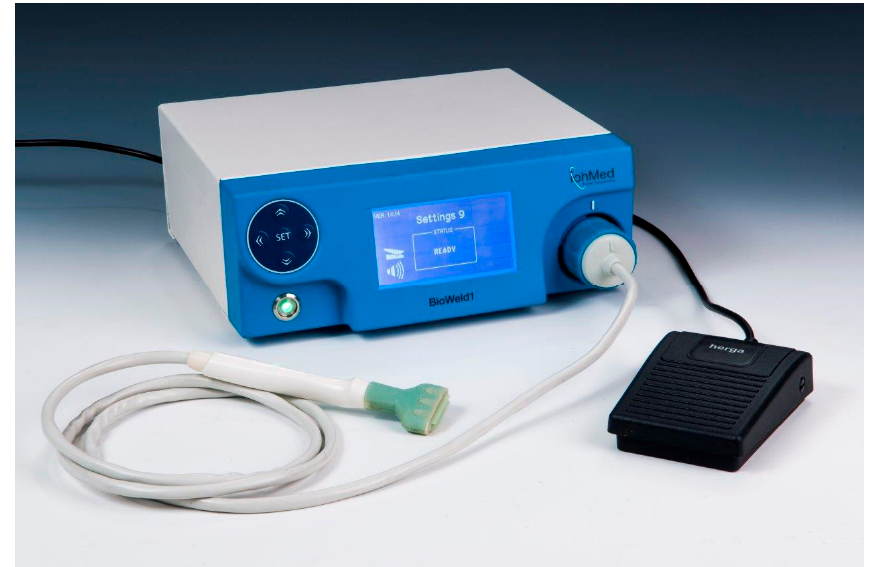
Figure 1. The BioWeld1 System consists of a plasma ejector base unit (height 12 cm, width 32 cm), a hand-piece with a cable, a plasma tip and a foot switch.